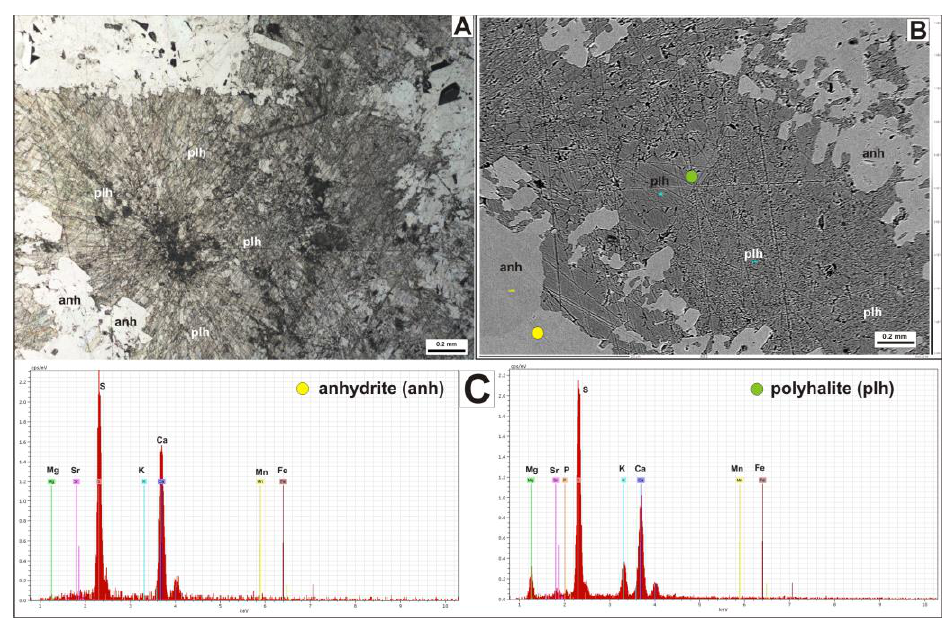
Figure 11. Thin section study, Mieroszyno M-9 borehole, sample M-9/2, depth 770.72 m. Sample location on Figure 2. ( A ) Radial and tabular crystals of polyhalite (plh, grey) and anhydrite plates (anh, white), microscope image (II polars). ( B ) SEM image of analysed anhydrite and polyhalite crystals with microprobe results; ( C ) colour dots—analytic points.